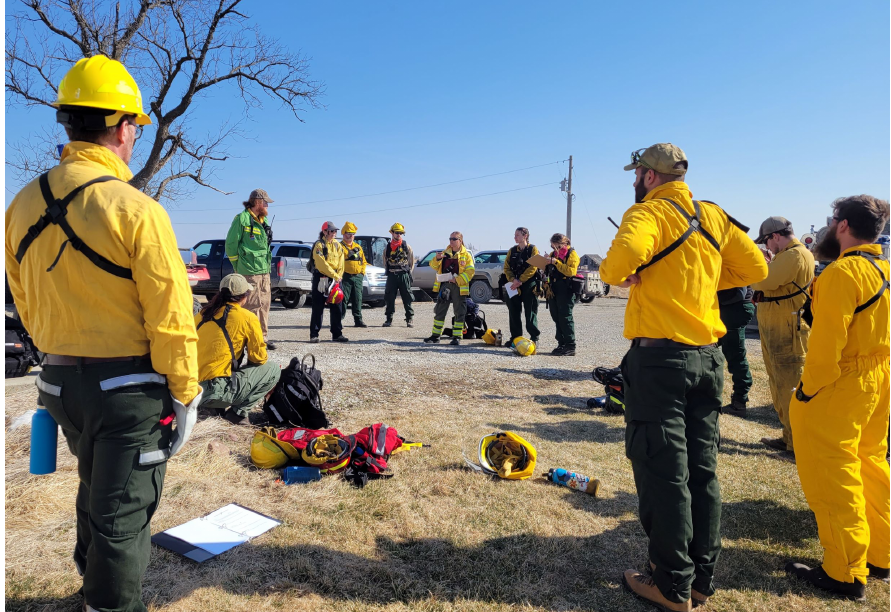
Figure 11. The cadre organized daily briefings to communicate the day’s activities and objectives to workshop